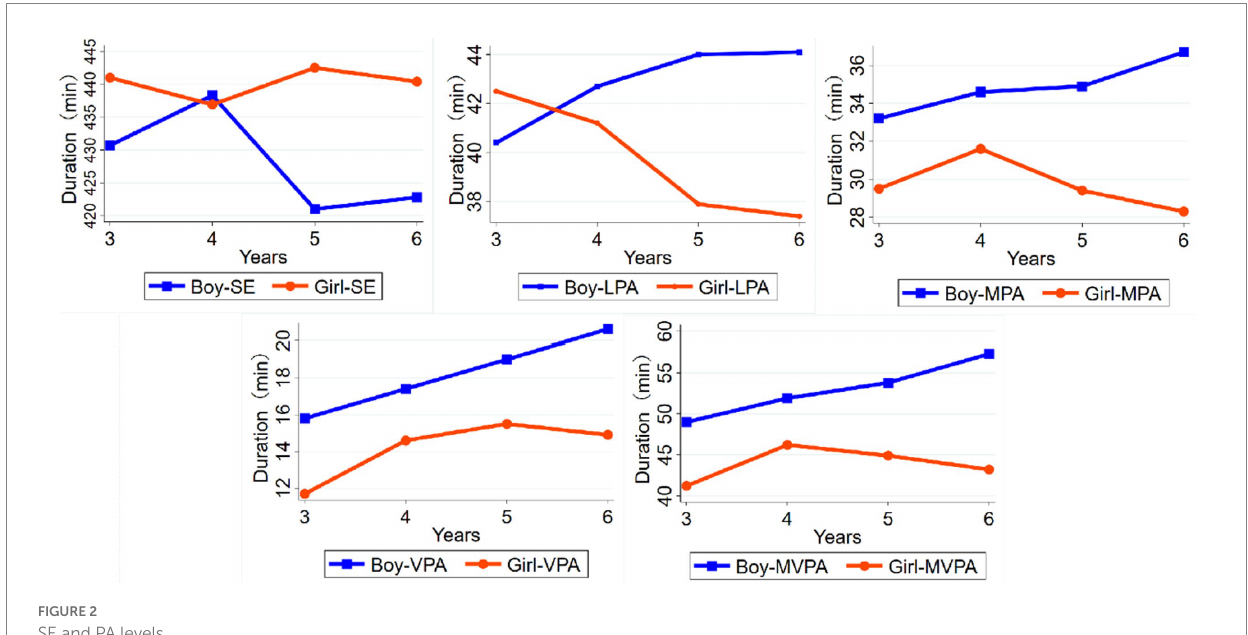
FIGURE 2 SE and PA levels.